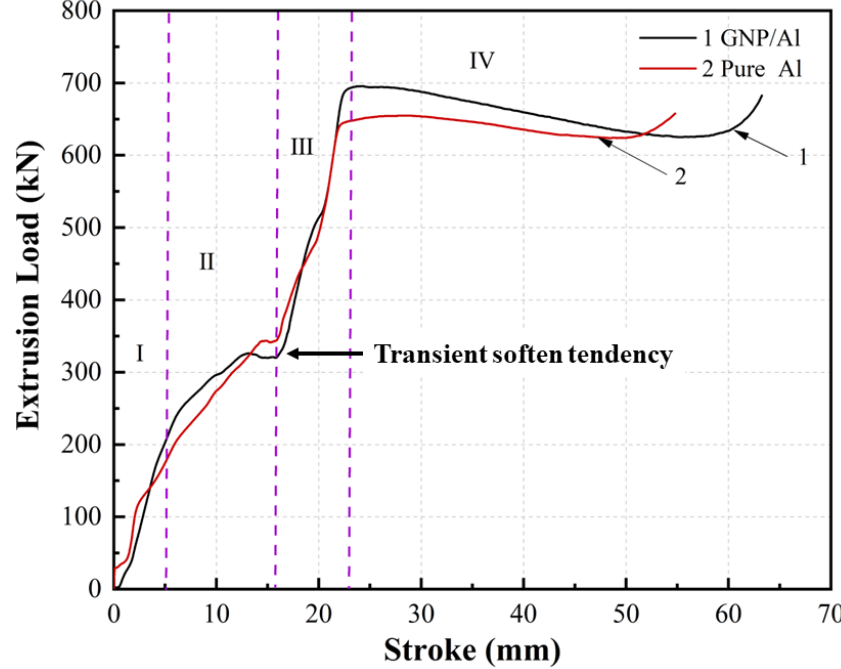
Figure 4. Load-displacement curve during the extrusion.